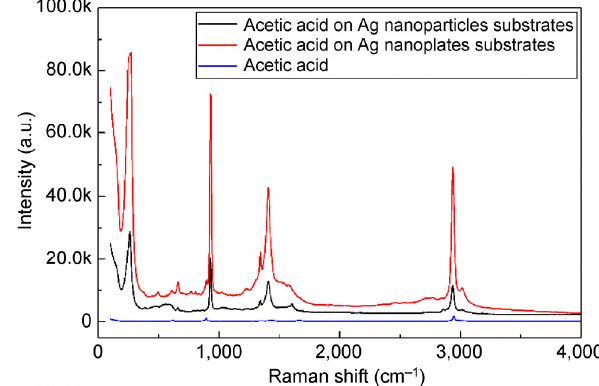
Fig. 8 Surface enhanced Raman technique by using silver substrates with nano structure reported by Gao et al. [78]. Copyright 2014, Royal Society of Chemistry.